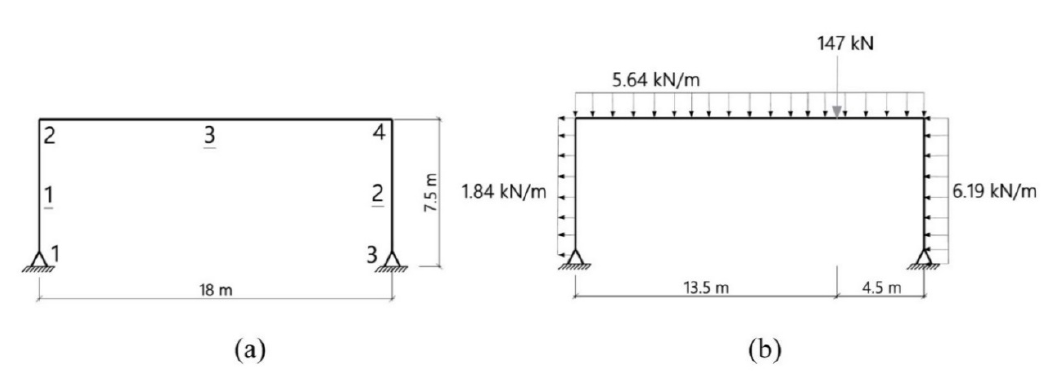
Figure 5 - Single-span single-story frame: (a) dimensions and numbering (b) design loads. Source: Authors (2020).